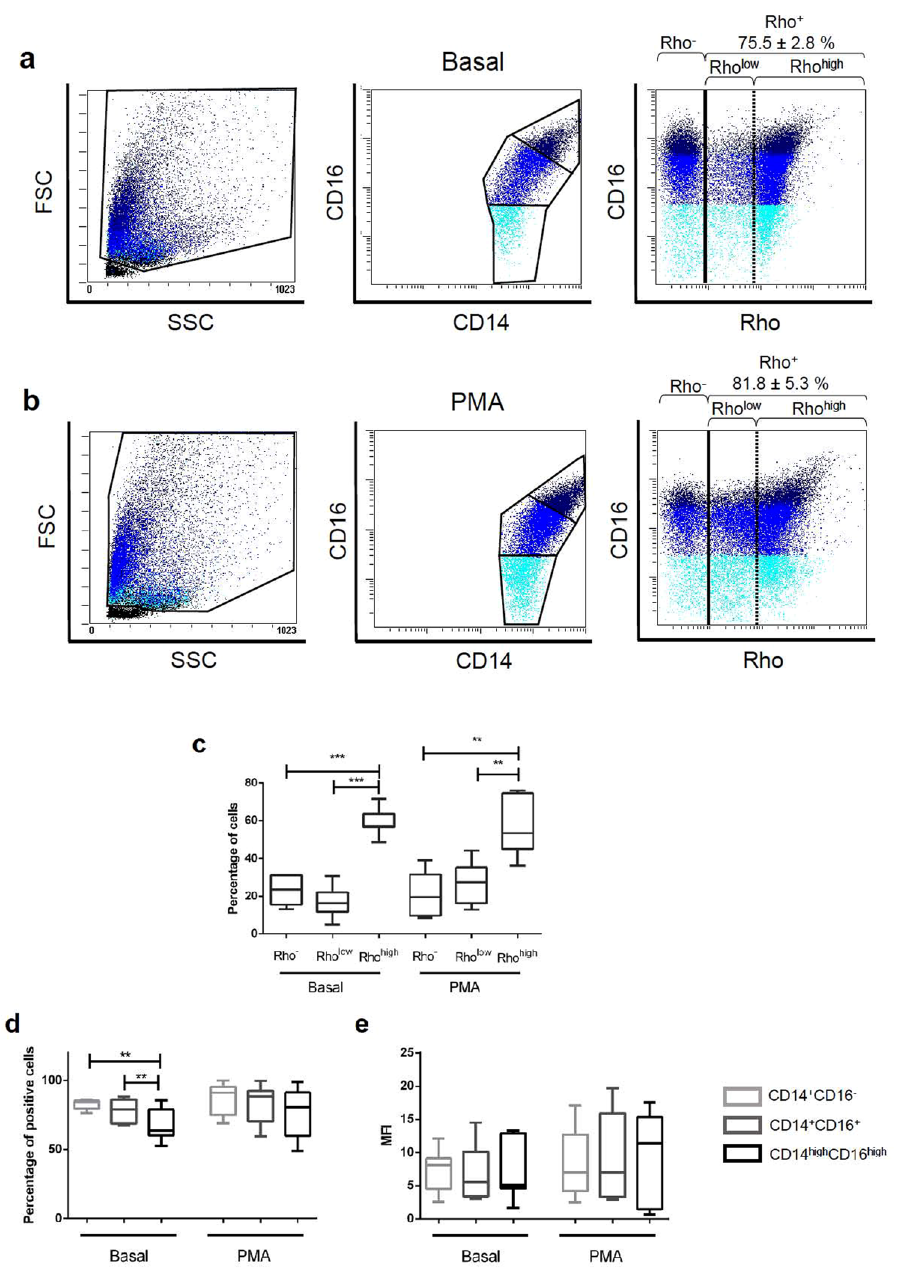
Figure 5. Flow cytometry analysis of the oxidative potential of human peritoneal monocyte/macrophages. Oxidative potential was measured by using a dihydrorhodamine 123 (DHR)-based assay. Positive oxidative cells were detected following ROS oxidation of DHR to green fluorescent rhodamine 123 (Rho). Representative FACS dot-plots of unstimulated (basal) peritoneal cells incubated with DHR are displayed. Dot-plots panels show forward/side scatter distribution of cells, CD14/CD16 gating, and Rho production in each cell subset ( a ). The same representative information is represented for PMA-stimulated cells ( b ). Light blue: CD14 ++ CD16 − subset; bright blue: CD14 ++ CD16 + subset; dark blue: CD14 high CD16 high subset. The black line corresponds to the division between positive and negative cells (percentages of Rho-positive cells are displayed); the dotted line indicates the two different Rho + subsets in terms of expression: Rho low and Rho high . Boxes and whiskers graphic represents: Percentages of cells subsets separated by Rho expression for basal and PMA-stimulated cells. Mann- Whitney U test among the three Rho subsets: ** p < 0.01, *** p < 0.001 ( c ); Distribution (%) of Rho-positive cells into the three CD14/CD16 subsets, for basal and PMA-stimulated cells. Mann-Whitney U test among the three CD14/CD16 subsets: ** p < 0.01 ( d ); Rho MFI of the three CD14/CD16 subsets ( e